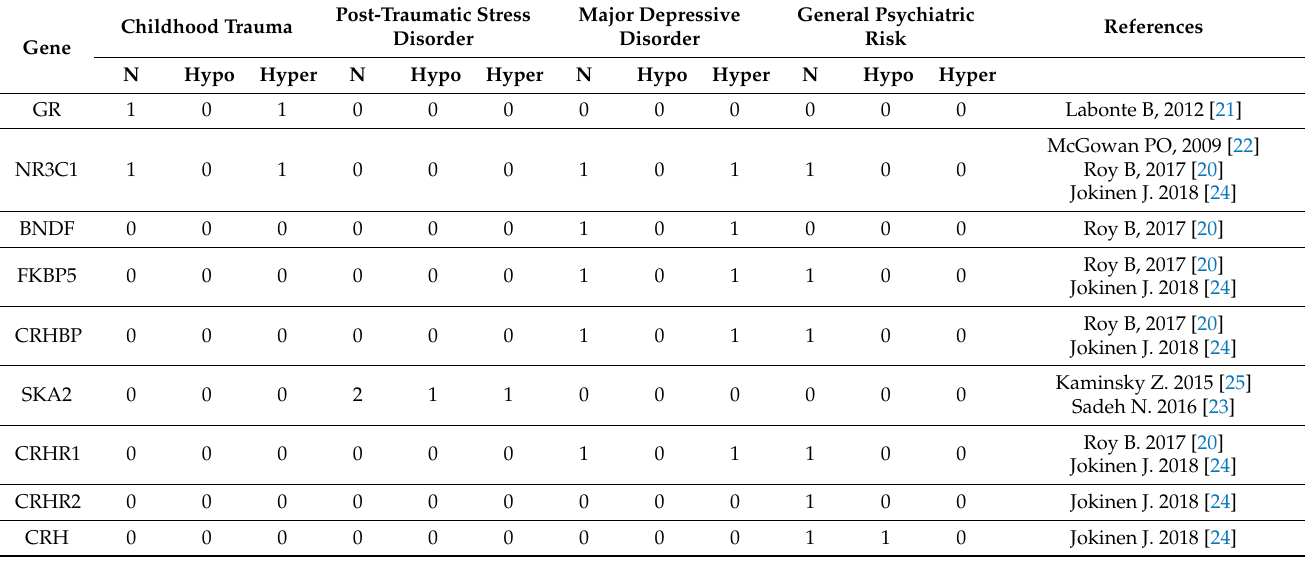
Table 3. The methylation state of genes that influence the activation of the HPA axis and reported in ELS, PTSD, MDD, and psychiatric